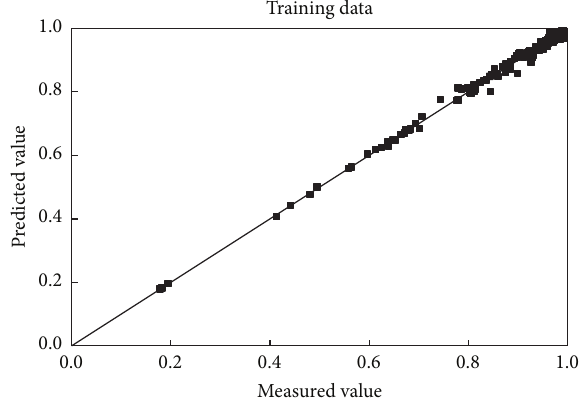
Figure 2: Comparison of the predicted and measured wall factor of the spheres for the training